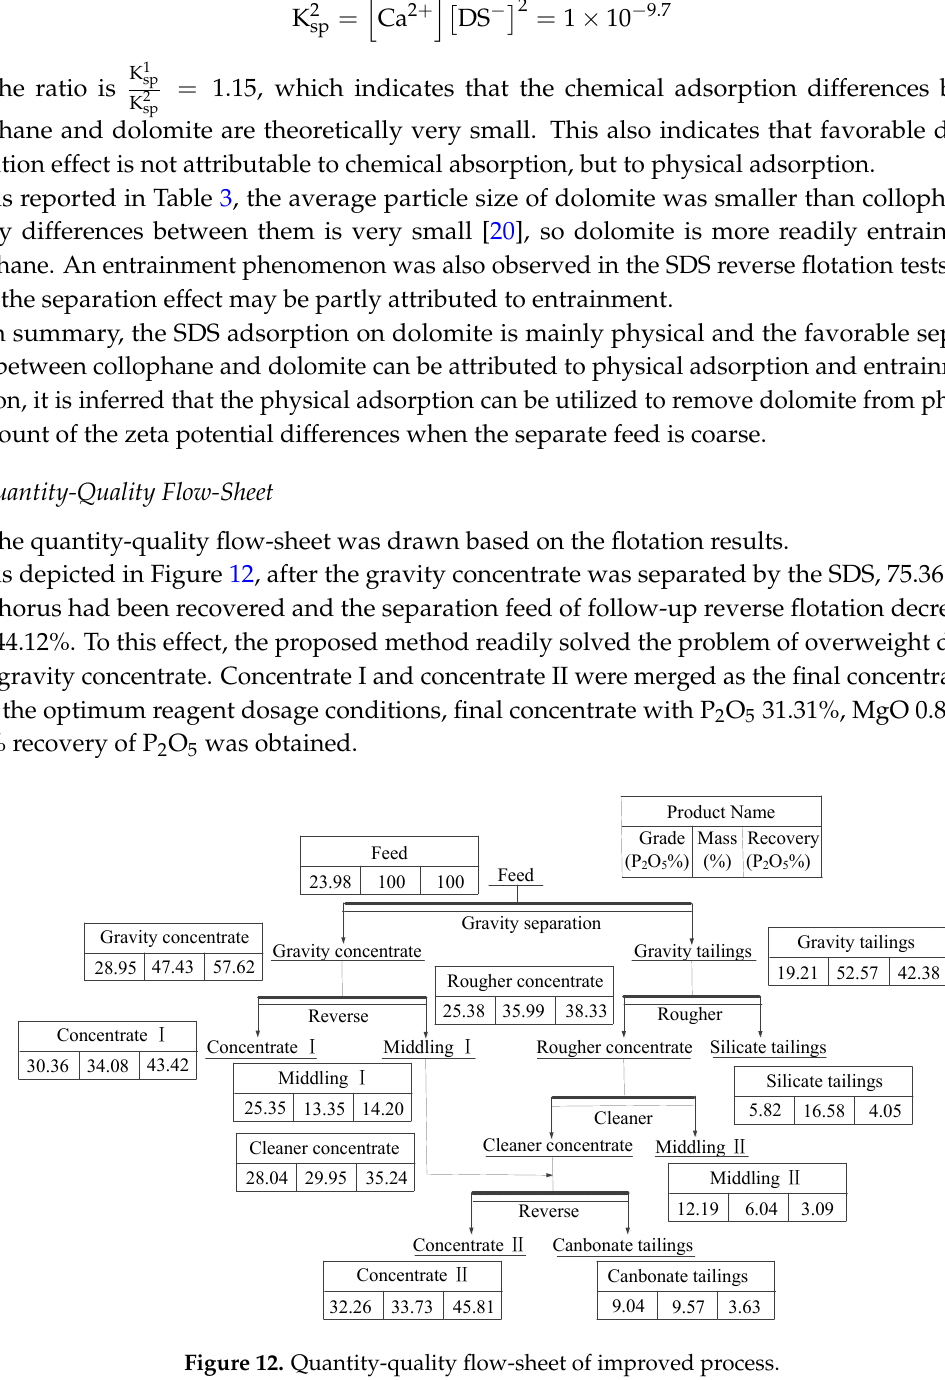
Table 6. Optimum reagent dosages of two processes.